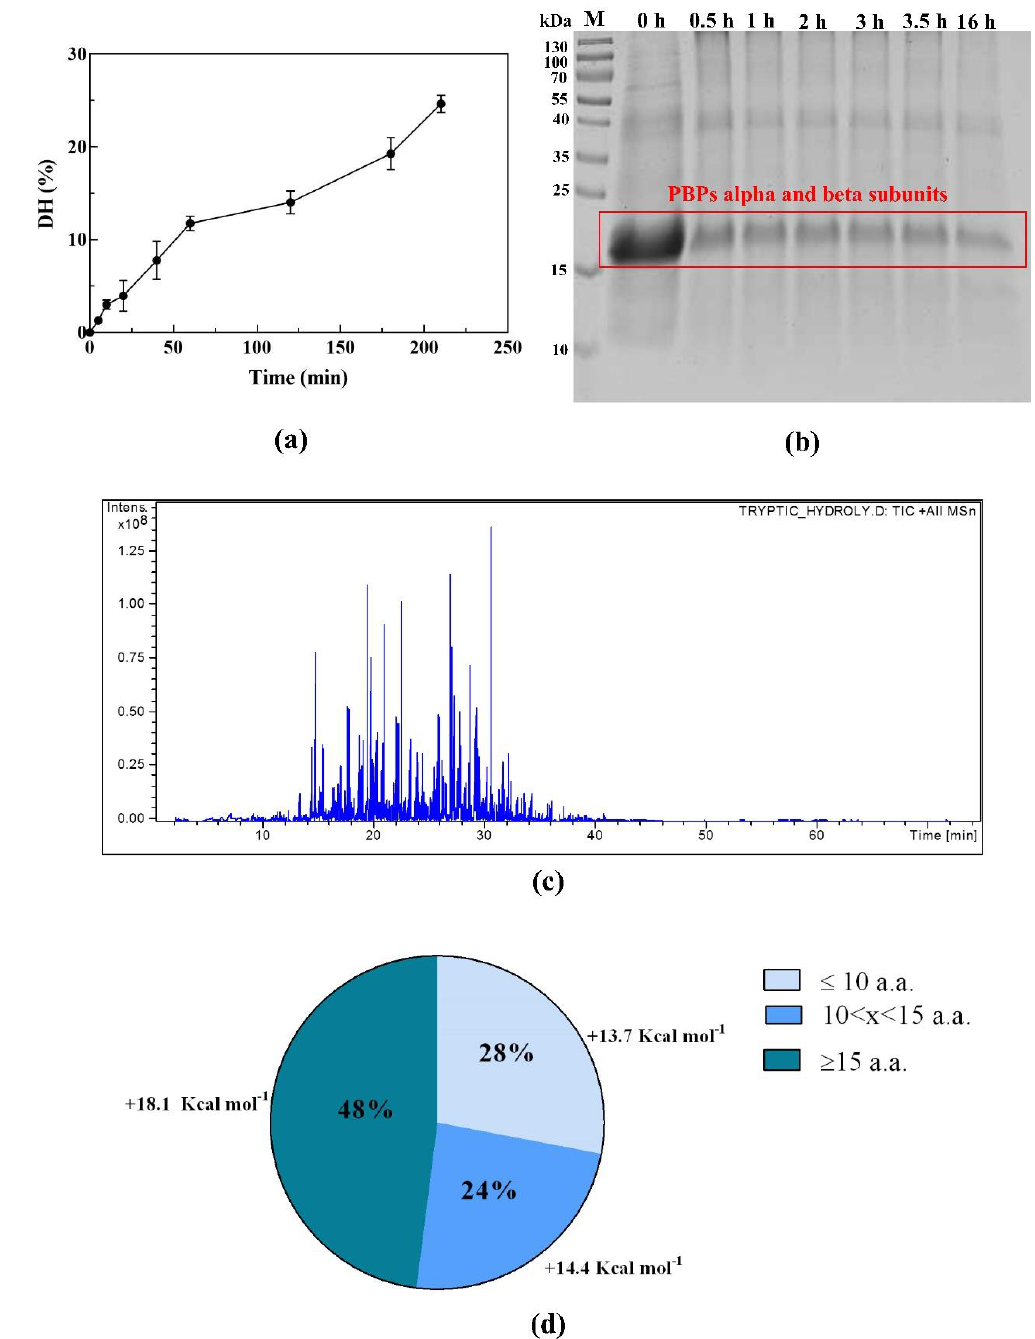
Figure 1. The preparation and analysis of the tryptic PBP hydrolysate. ( a ) The trend of degree of hydrolysis (DH) versus time in the first 3.5 h of digestion with trypsin. ( b ) The SDS-PAGE analysis of the hydrolysis sampled at different time points. ( c ) The total ion chromatogram (TIC) of the phycobiliprotein (PBP) hydrolysate. ( d ) The length and hydrophobicity distribution of the peptides from the PBP hydrolysate.